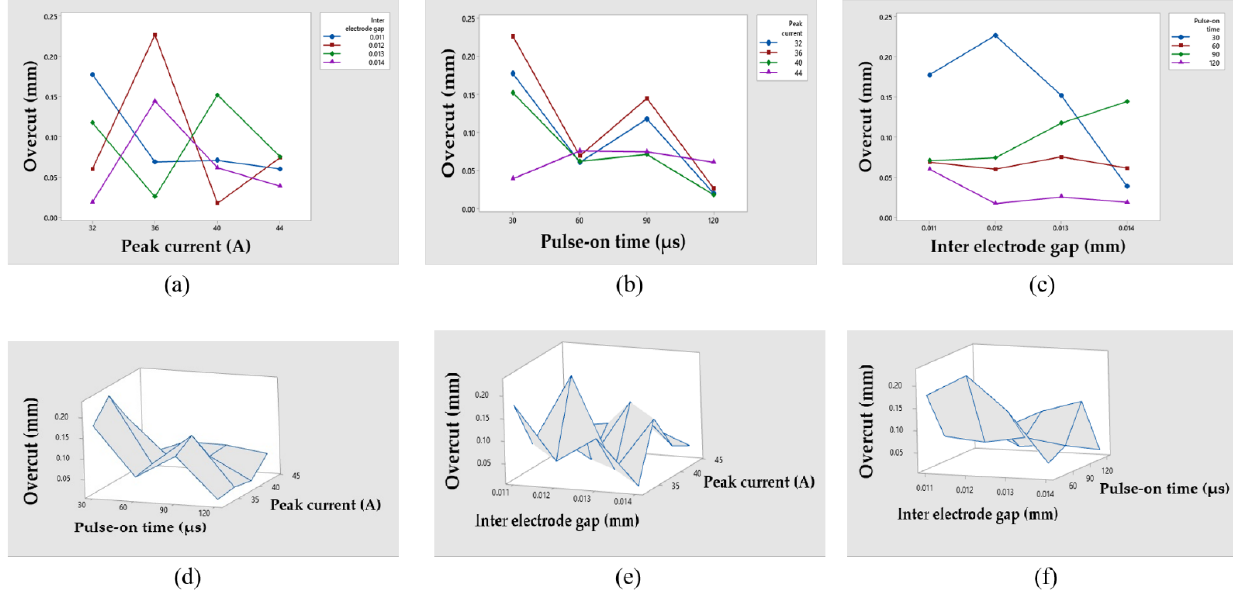
Figure 5. Effects of different EDM process parameters on Overcut with its surface plots. ( a ) Influence of T on on Overcut. ( b ) Influence of IEG on Overcut. ( c ) Influence of I on Overcut. ( d ) Overcut vs. I and T on . ( e ) Overcut vs. I and IEG. ( f ) Overcut vs. T on and IEG.